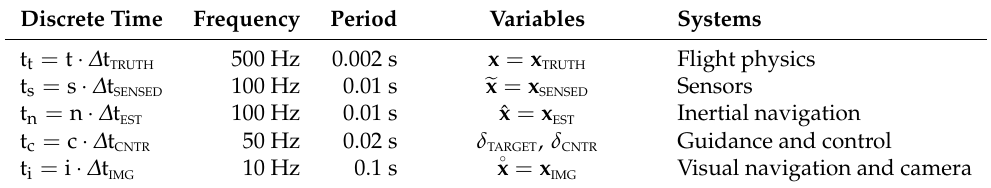
Table 3. Working frequencies of the different systems and trajectory representations.